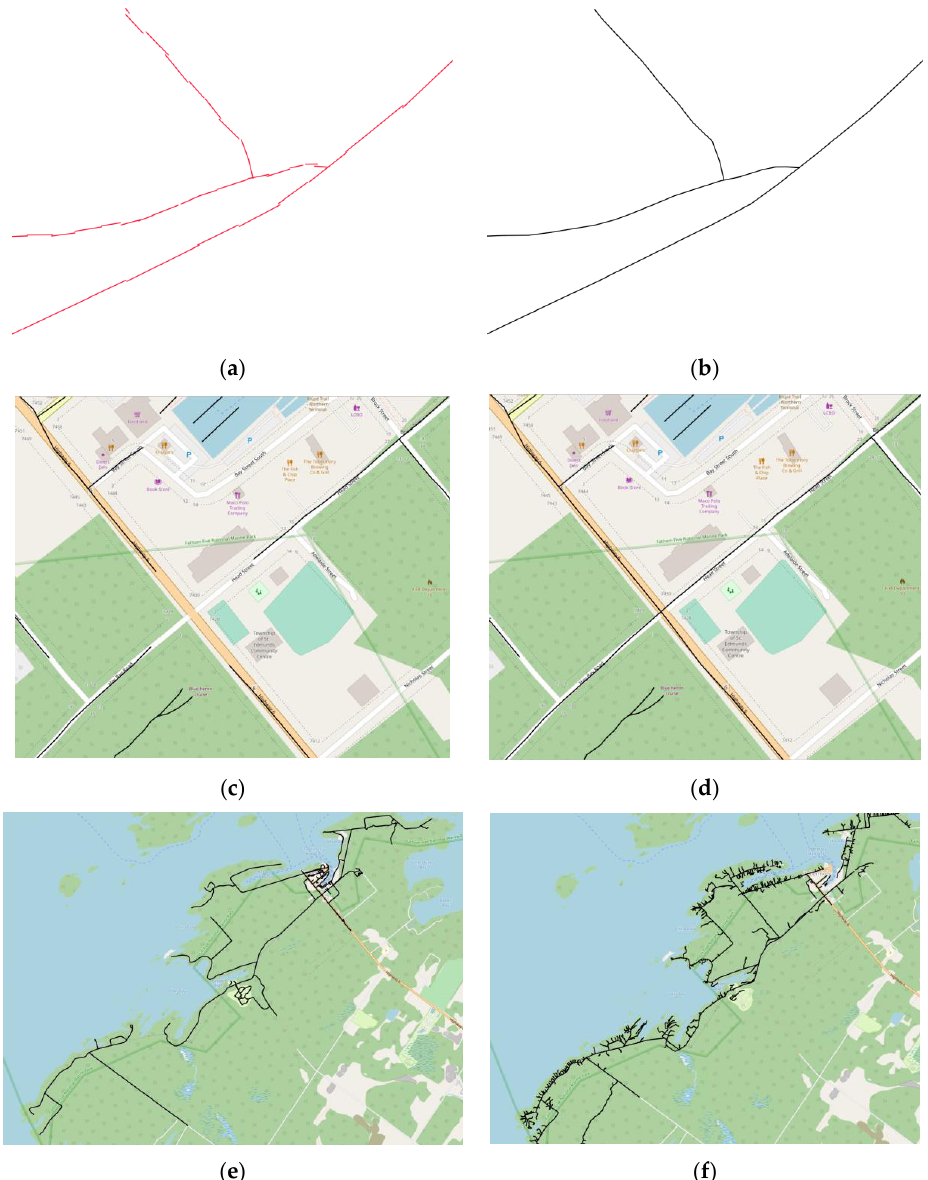
Figure 8. Road centerline extraction: ( a , b ) example of road line regularization, not regularized (on the left) and regularized (on the right), ( c , d ) road connectivity before (on the left) and after (on the right) the cell complex connectivity, and ( e , f ) Tobermory road network, OpenStreetMap (OSM — on the left) and the roads extracted with the proposed method (on the right).